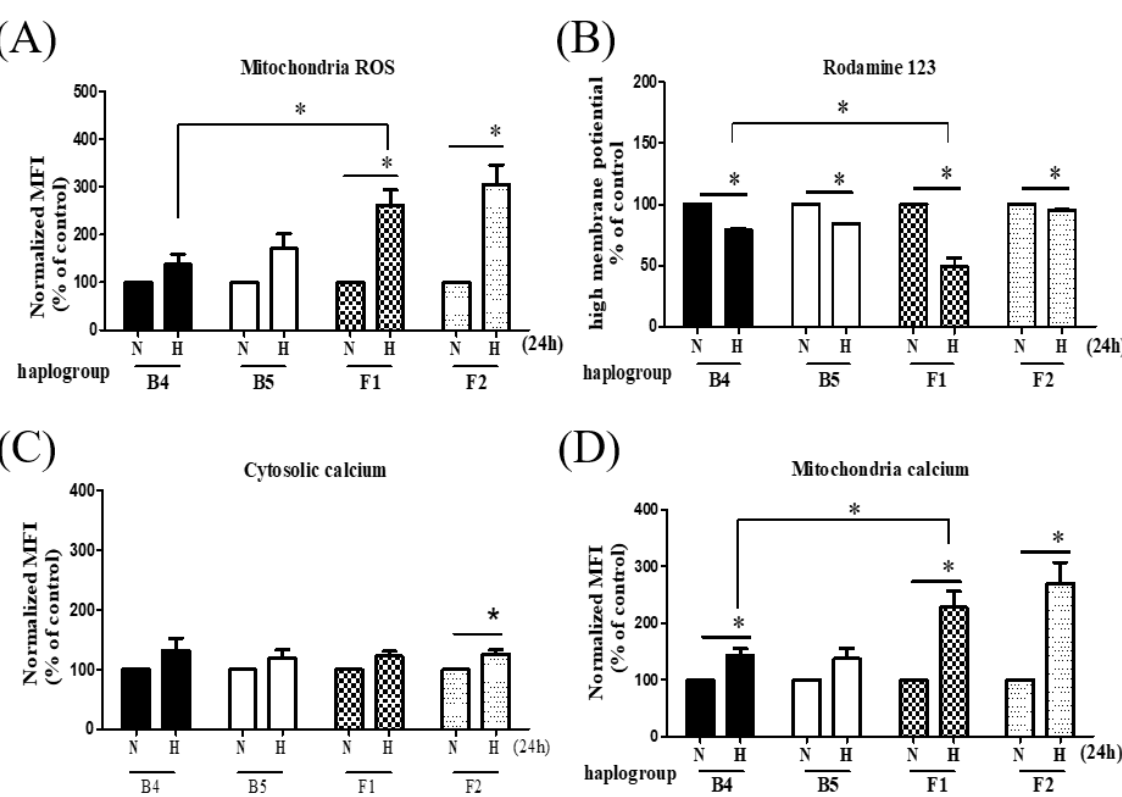
Figure 3. Mitochondrial profile of di ff erent cybrids after hypoxia-ischemia. Comparison of mitochondrial ROS ( A ), mitochondrial transmembrane potential ( B ), cytosolic calcium levels ( C ), and distribution of mitochondrial calcium ( D ) under hypoxic-ischemic conditions in cybrid cells harboring stroke-susceptible haplogroup F and stroke-resistant haplogroup B. MitoSOX-based flow cytometry was used for detecting mitochondrial ROS. The fluorescence of mitochondrial transmembrane potential was measured by Rhodamine 123. The mobilization of distinct pools of calcium between cytosolic and mitochondria, stained with Fura2-AM and Rhod-2 AM, respectively, were measured by flow cytometry analysis. Data represent the mean ± SD of at least three independent experiments ( * p < 0.05). N was used to represent normoxic and H to represent the hypoxic